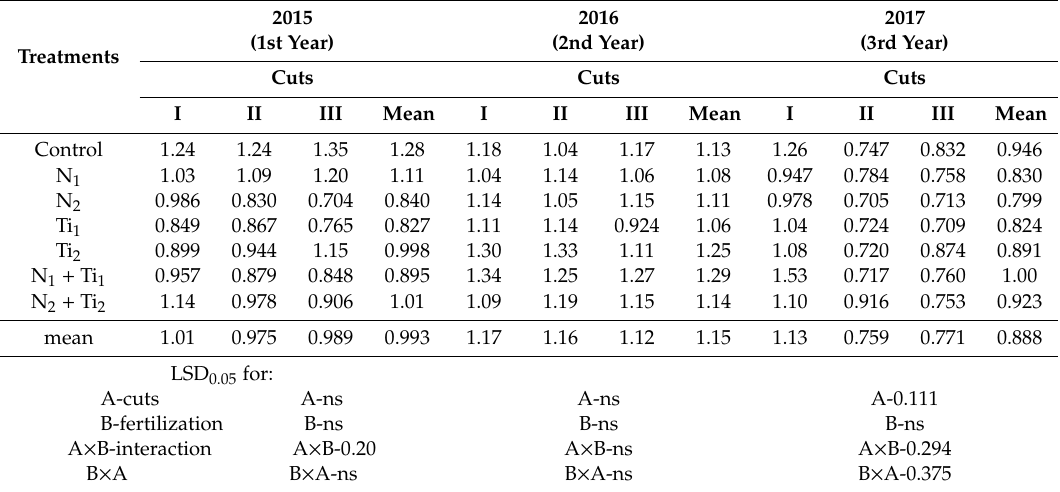
Table 3. Total protein content in Festulolium braunii (g kg − 1 DM). the sugar-protein ratio in the biomass of Festulolium braunii treated with NPK fertilizers in combination with soil conditioners was much lower, with 0.51. Table 5. The sugar-protein ratio in Festulolium braunii dry matter.